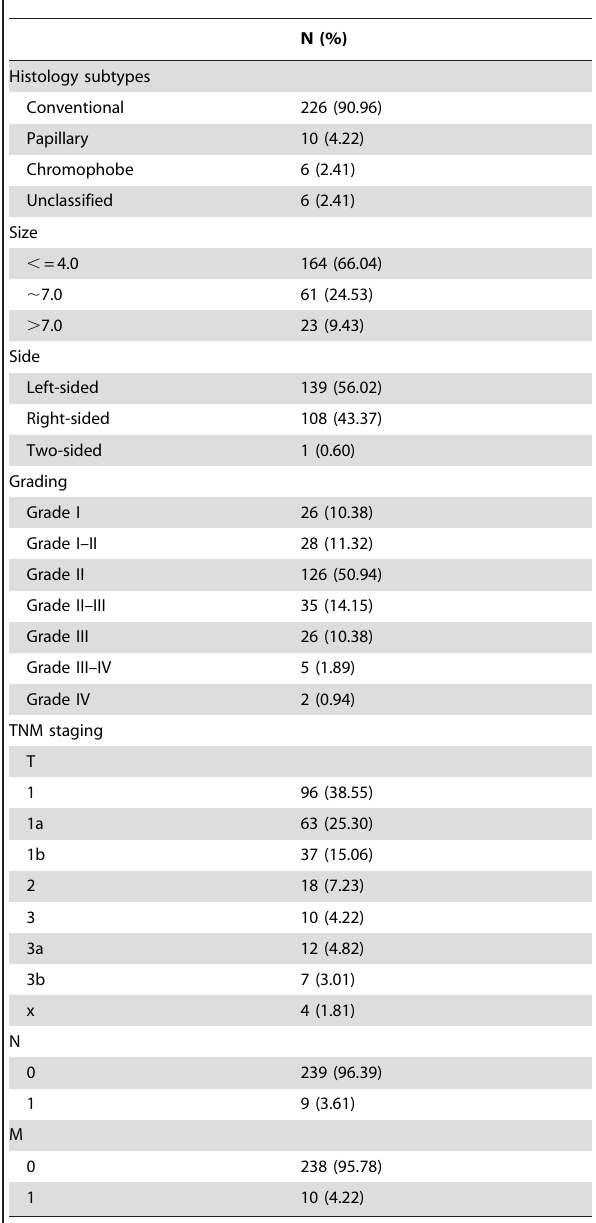
Table 2. Description of the renal cell